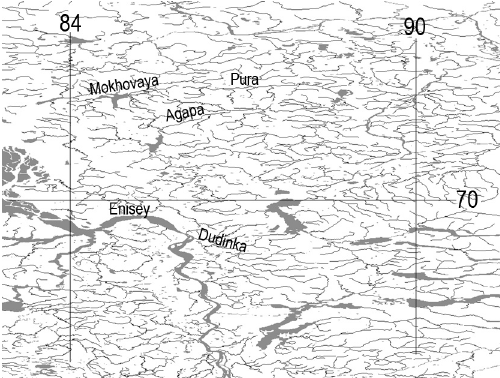
Fig. 6. Map of Gydanskaya Gryada Upland calving grounds.